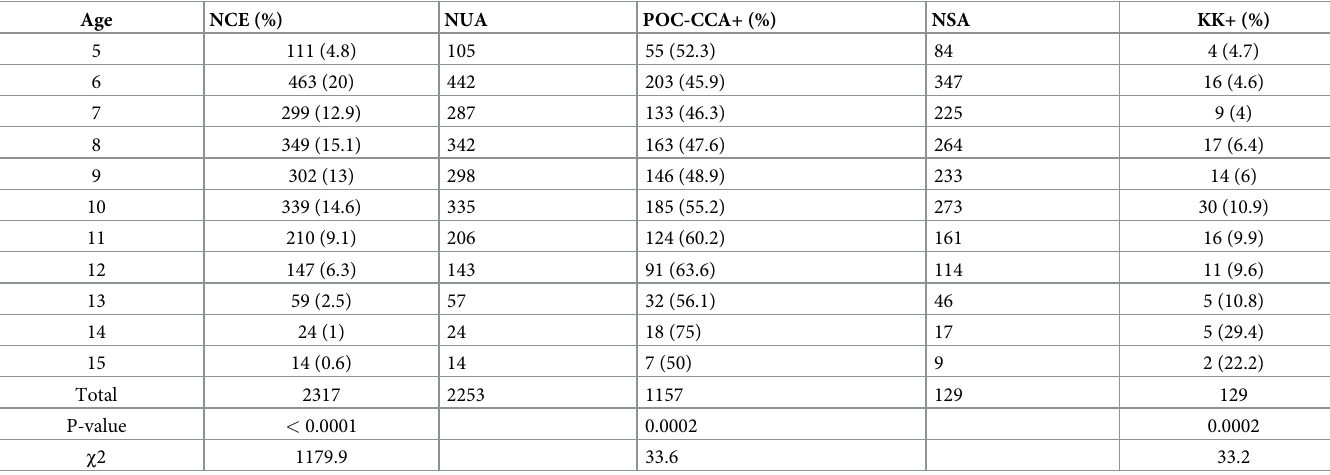
Table 1. Prevalence of S. mansoni infections according to